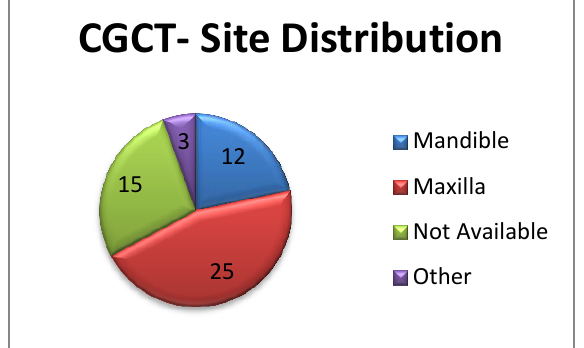
Figure 1: Site distribution